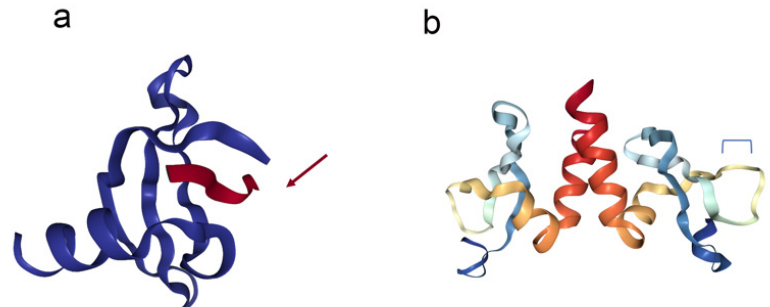
Figure 1. The crystal structure of the CHD (left) and CSD (right) of HP1a. ( a ) The left image is a representation of the chromodomain (blue ribbons) of HP1 complexed with histone H3K9me3 from Drosophila (red ribbon mark with red arrow). The CHD (69 aa in length), is made up of three β -sheet antiparallel chains flanked by an α -helix on the C-terminal. The histone tail (16 aa) inserts as a β -strand, completing the β -sandwich architecture of the CHD. ( b ) On the right side is the CSD with the C-terminal region (rainbow ribbons) of HP1a from Drosophila . The CSD (87 aa) is a dimeric domain and consists of three antiparallel β -sheet chains flanked by two α -helices. The blue bracket represents the interaction site of the PxVxL peptide. Images were created with the PDB (Protein Data Bank) ID 1KNE [36], 3P7J [42], and NGL Viewer [43] .